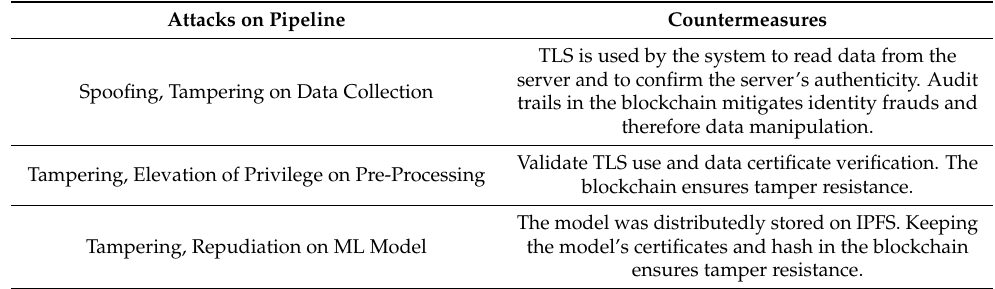
Table 11. Relevant Attacks and Countermeasures on the ML pipeline. Attacks on Pipeline Countermeasures Spoofing, Tampering on Data